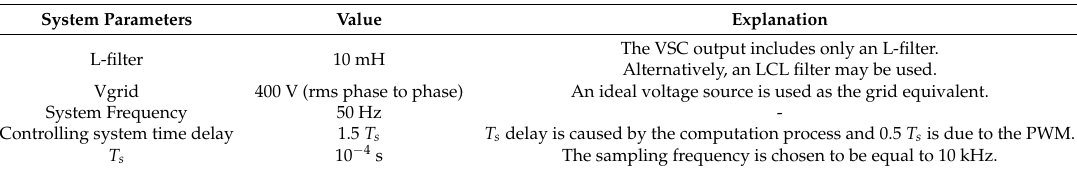
Table 2. System parameters for the grid-connected VSC.